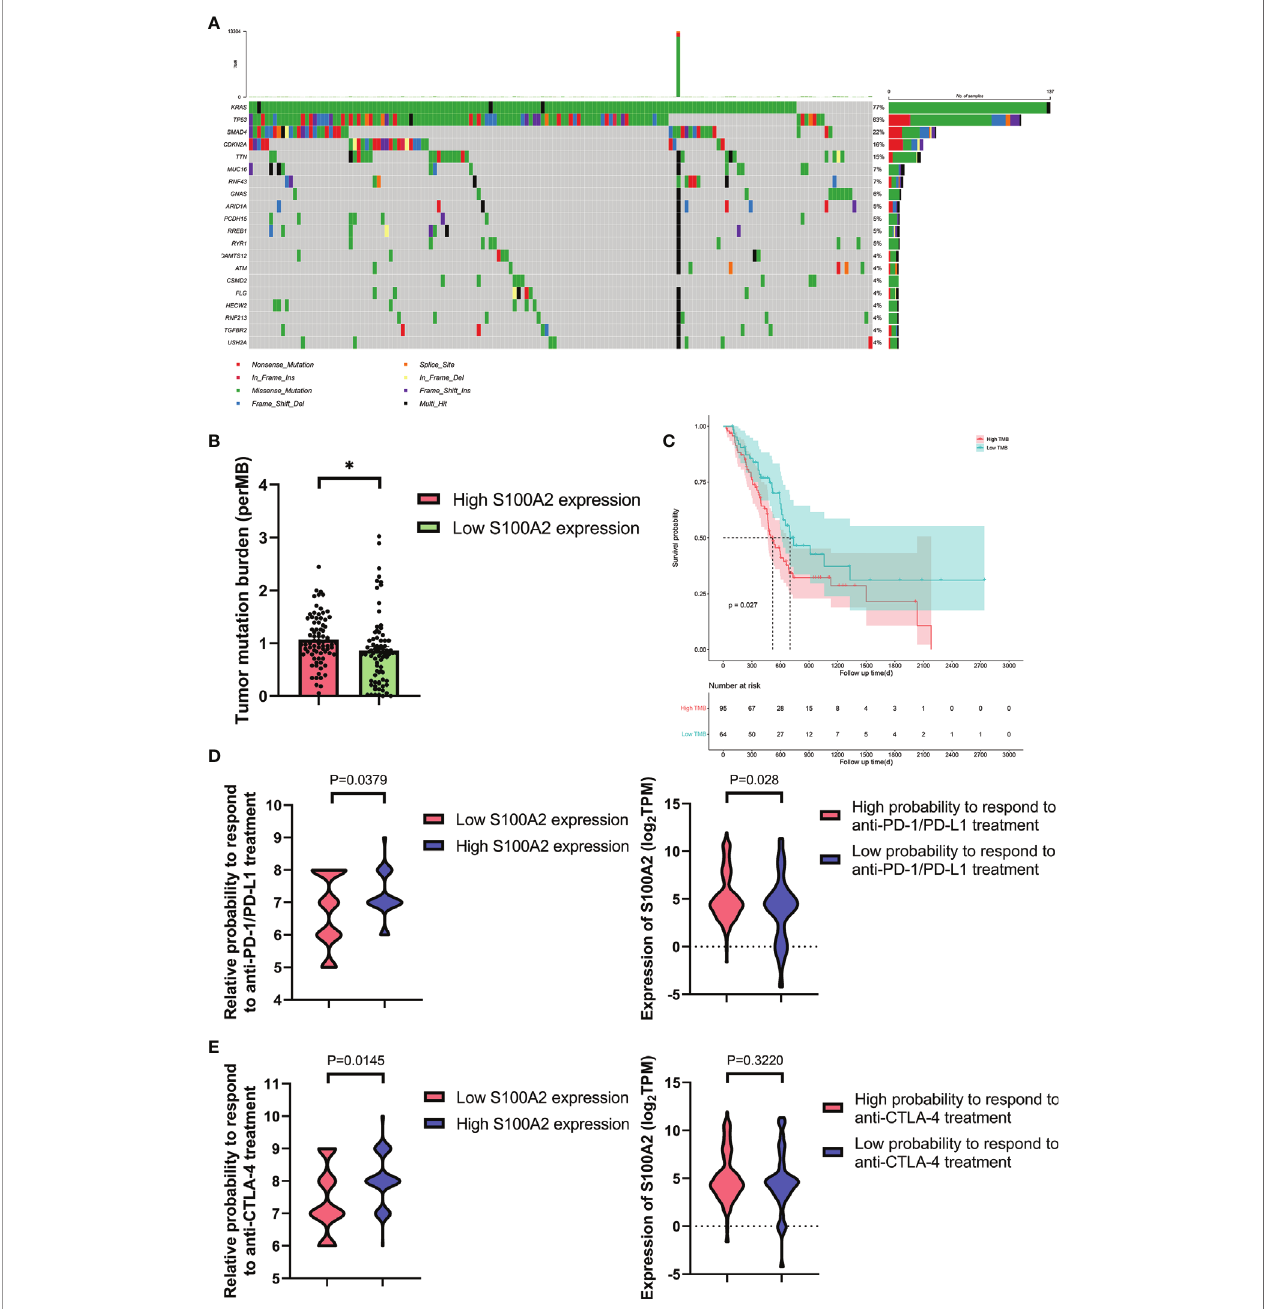
FIGURE 7 | Figure 7. The mutation pro fi le, TMB and relative probabilities to respond to immunotherapy in S100A2 high and low expression groups. (A) Mutation pro fi le of PC patients in TCGA dataset. (B) The difference of TMB between S100A2 high and low expression groups. (C) Kaplan-Meier analysis of OS between the high TMB group and low TMB group. (D, E) The association between S100A2 expression and the relative probabilities to respond to immunotherapy, including anti- PD-1/PD-L1 therapy and anti-CTLA-4 therapy. *P <